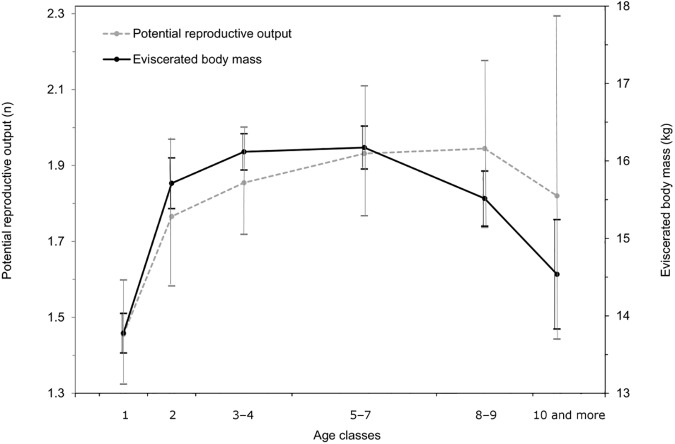
Age-dependent differences in mean eviscerated body mass and potential reproductive output (number of CL, including infertile individuals) in roe deer females in Slovenia (n = 1312).Error bars denote 95% confidence intervals of the mean. Note that age was estimated using macroscopic inspection of tooth-wear, a method that is less accurate (especially) in older animals.